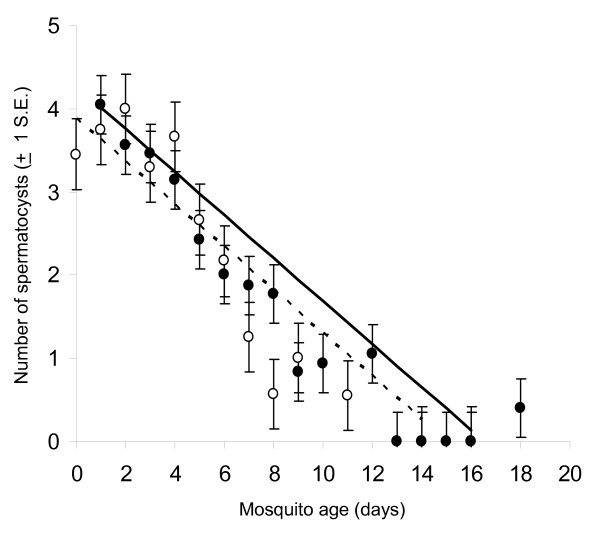
The progressive decline of spermatocyst number with age and mating in male An. gambiae. Lines give the best fit relationship between male age and spermatocyst number as obtained by linear regression for virgin males (dotted line and open circles) and males who had mated once (solid line and closed circles).